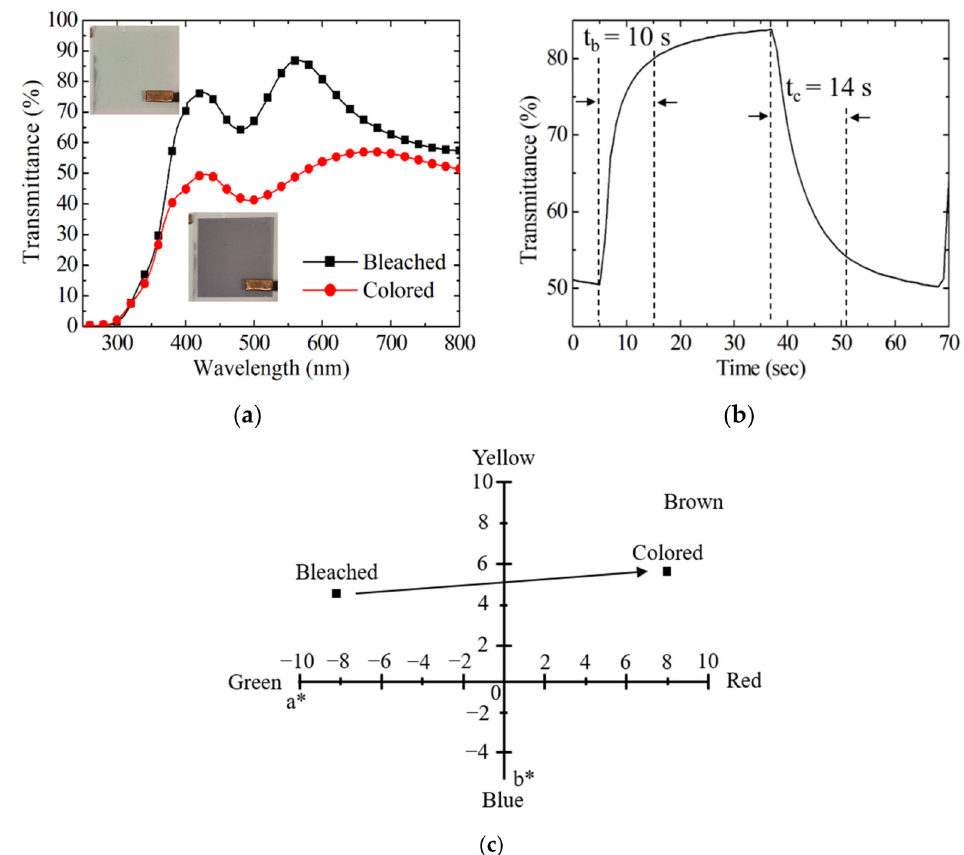
Figure 14. ( a ) Measured transmittance spectra, ( b ) response time, ( c ) chromaticity diagram of the EC device with 48 nm thick TiO 2